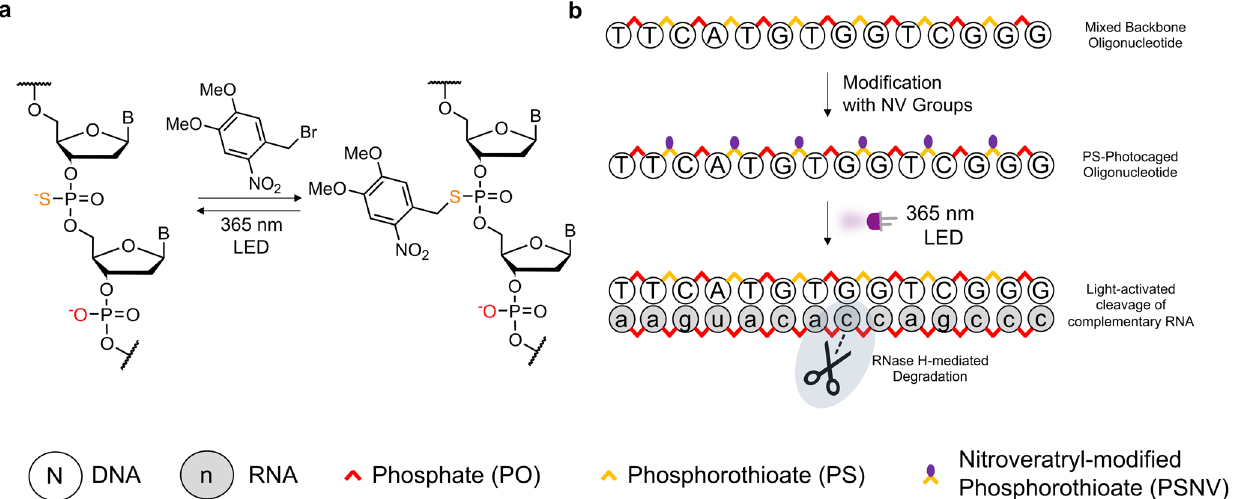
Fig. 1 Modi fi cation of PS-containing antisense oligonucleotides and our approach to using them in controlling RNase H-mediated gene knockdown. a Chemoselective modi fi cation of PS-linkages in a mixed backbone oligonucleotide with 2-nitroveratryl bromide, and subsequent uncaging following UV irradiation. b Caging of a mixed backbone antisense oligonucleotide with 2-nitroveratryl bromide to silence RNase H activity. UV irradiation uncaged the antisense oligonucleotide, activating RNase H-mediated target mRNA